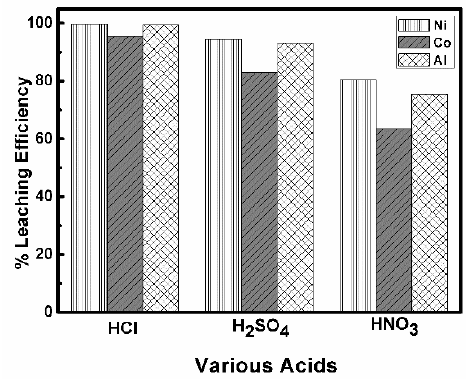
Figure 4. The effect of various acids on the leaching efficiency of NCA scrap (4M, 80 °C, 1 h).